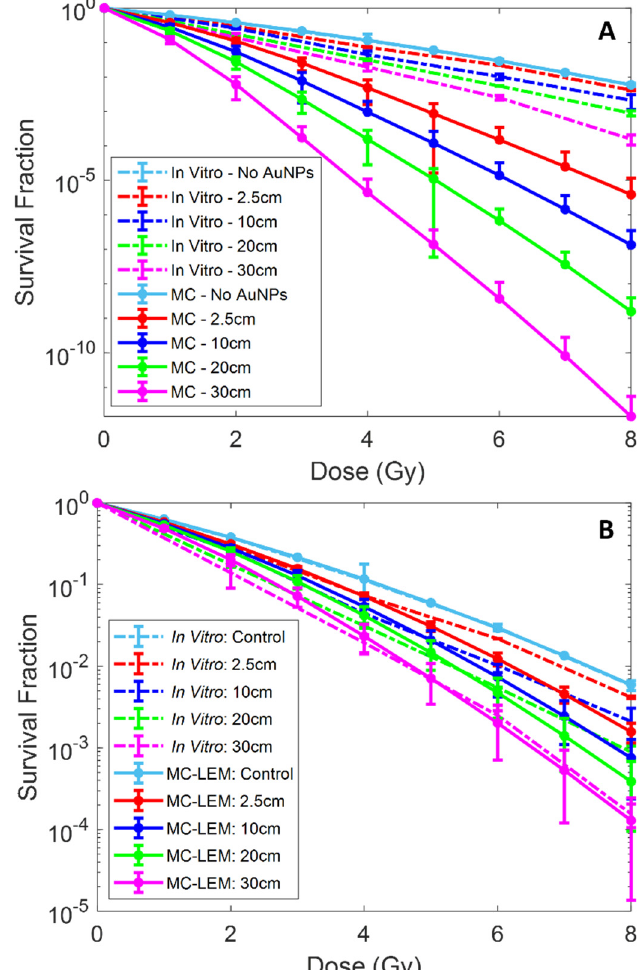
Figure 9. Monte Carlo (MC) and local effect model (LEM) calculated survival fraction curves at various depths for 10 pg/cell AuNPs using ‘homogenous’ model, ( A ), and ‘cytoplasm’ model, ( B ). Additionally, the in vitro clonogenic assay derived survival fraction curves are shown at corresponding depths for comparison. Table 4. Sensitization enhancement ratio (SER) calculated on MC-LEM survival fraction curves for both homogenous and cytoplasm cell models, compared against that from in vitro clonogenic assay.